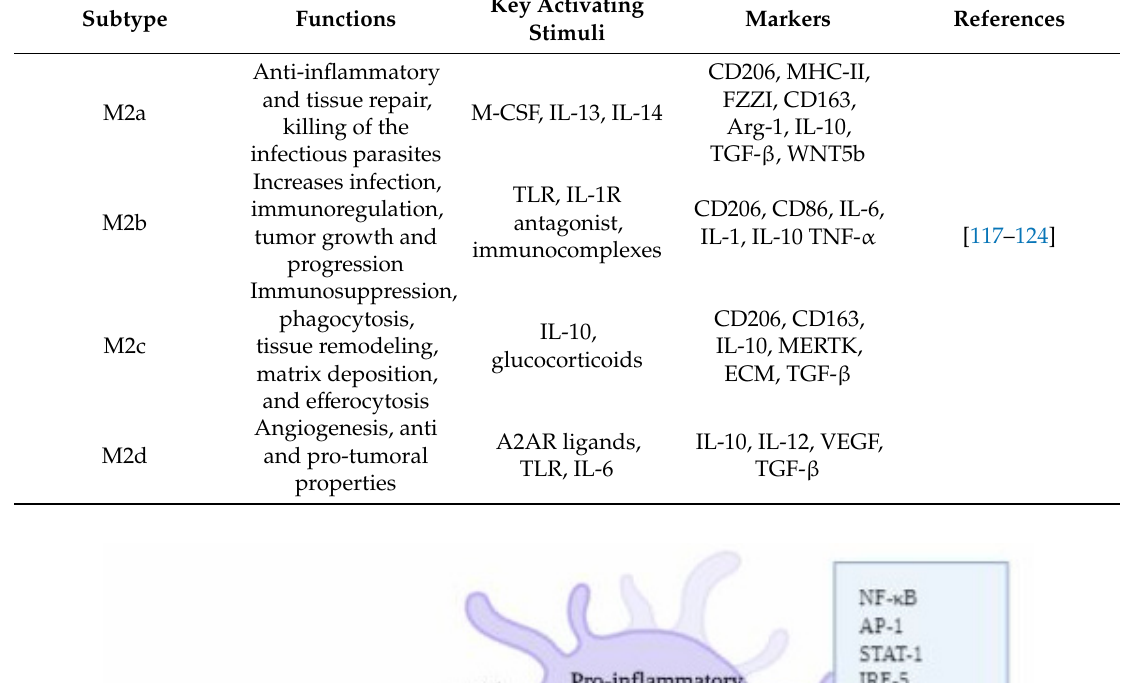
Table 2. Classification of M2-like macrophages.